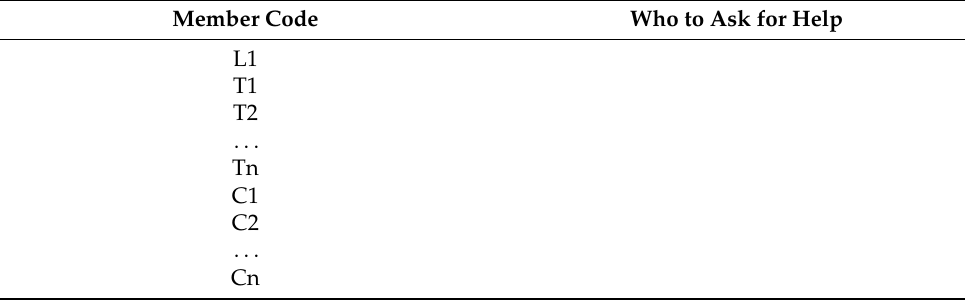
Table 3. The question to build the knowledge transfer network of